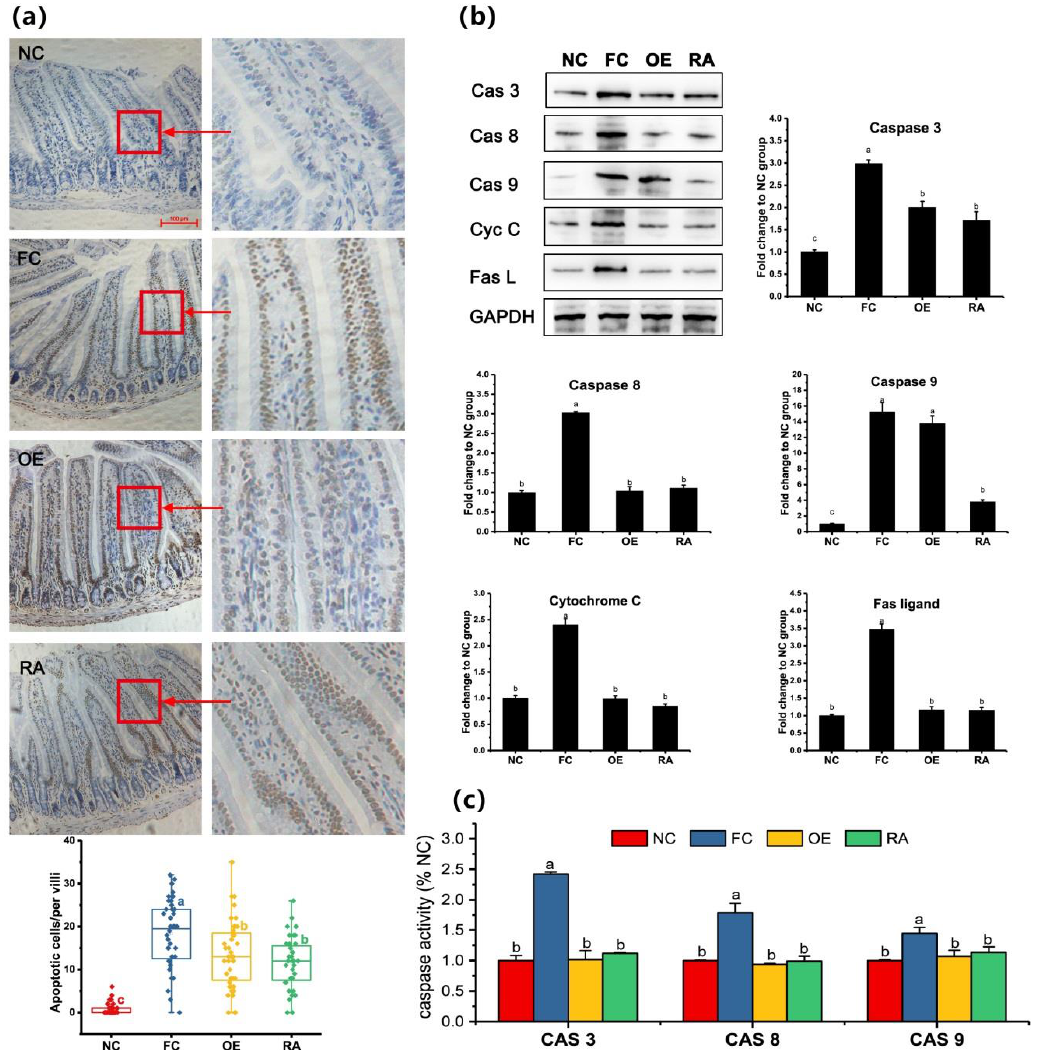
Figure 4. OE and RA inhibit intestinal cell apoptosis induced by a high-fat diet. ( a ) Terminal-deoxynucleoitidyl Transferase Mediated Nick End Labeling (TUNEL) assays of mouse jejunum after di ff erent treatments. The experiment was carried out with a kit from Boster (Wuhan, China). Apoptotic nuclei stain brown, and normal nuclei stain blue. The box-plot figure was draw in Origin software, and data are compared with Dunnett T3 by ANOVA ( n = 40). ( b ) Protein lysates from jejunal segments were examined by western blotting for caspase-3, -8, and -9, cytochrome C, and Fas ligand protein levels. Reduced glyceraldehyde-phosphate dehydrogenase gene (GAPDH) was used as the control. ( c ) Caspase activity of jejunal segments after di ff erent treatments. The activity of caspases was measured with substrate peptides. For ( b ) and ( c ), data are expressed as the fold change relative to the NC group and were compared with Duncan’s test by ANOVA. Di ff erent letters indicate significant di ff erences ( P < 0.05). Cas 3, caspase-3; Cas 8, caspase-8; Cas 9, caspase-9; Cyc C, cytochrome C; Fas L, Fas